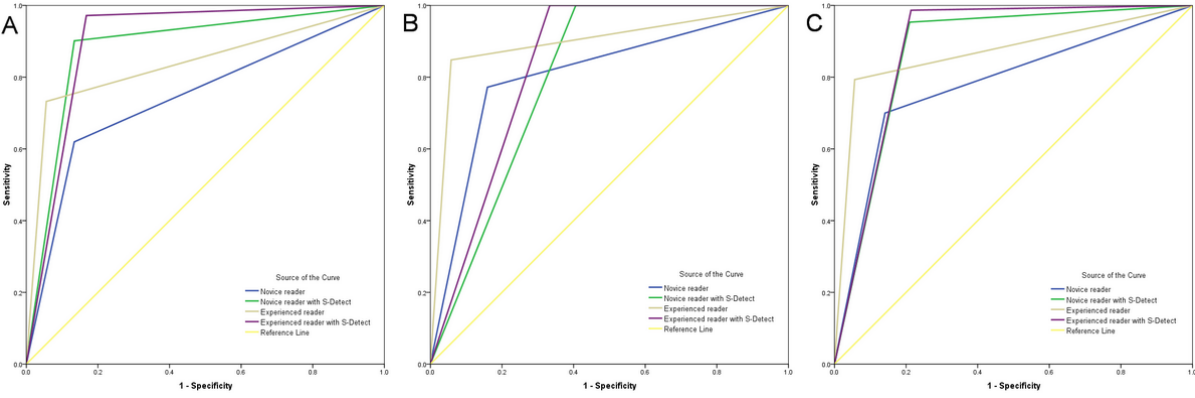
Figure 1. Comparison of receiver operating characteristic curves in lesions <2 cm, lesions >2 cm, and lesions in all